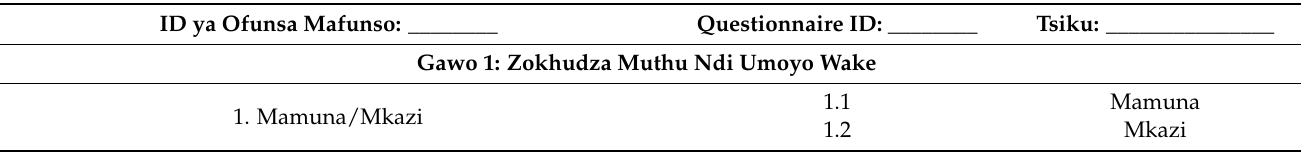
Table A2. Mafunso wokhudza Kuvomereza Katemera wa COVID-19.